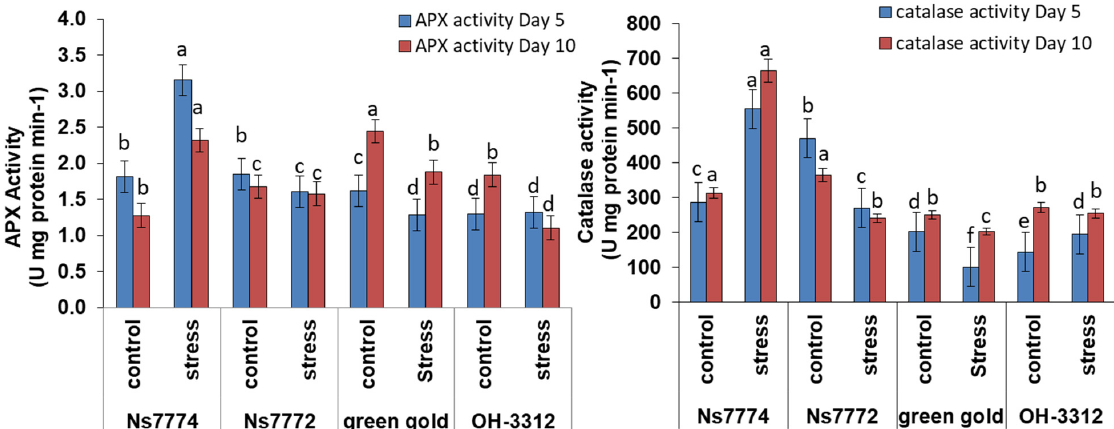
Figure 5. Changes in antioxidant enzyme activity: ascorbate peroxidase (APX) and catalase activity (CAT) activity, as affected by drought stress at 5 and 10 days of interval in okra genotypes NS7774, NS7772, Green Gold, and OH3312, along with respective controls. Vertical bars indicate mean ± SE for n = 5. Means denoted by the different letter are significantly different at p ≤ 0.05 according to the Tukey’s studentized range test.